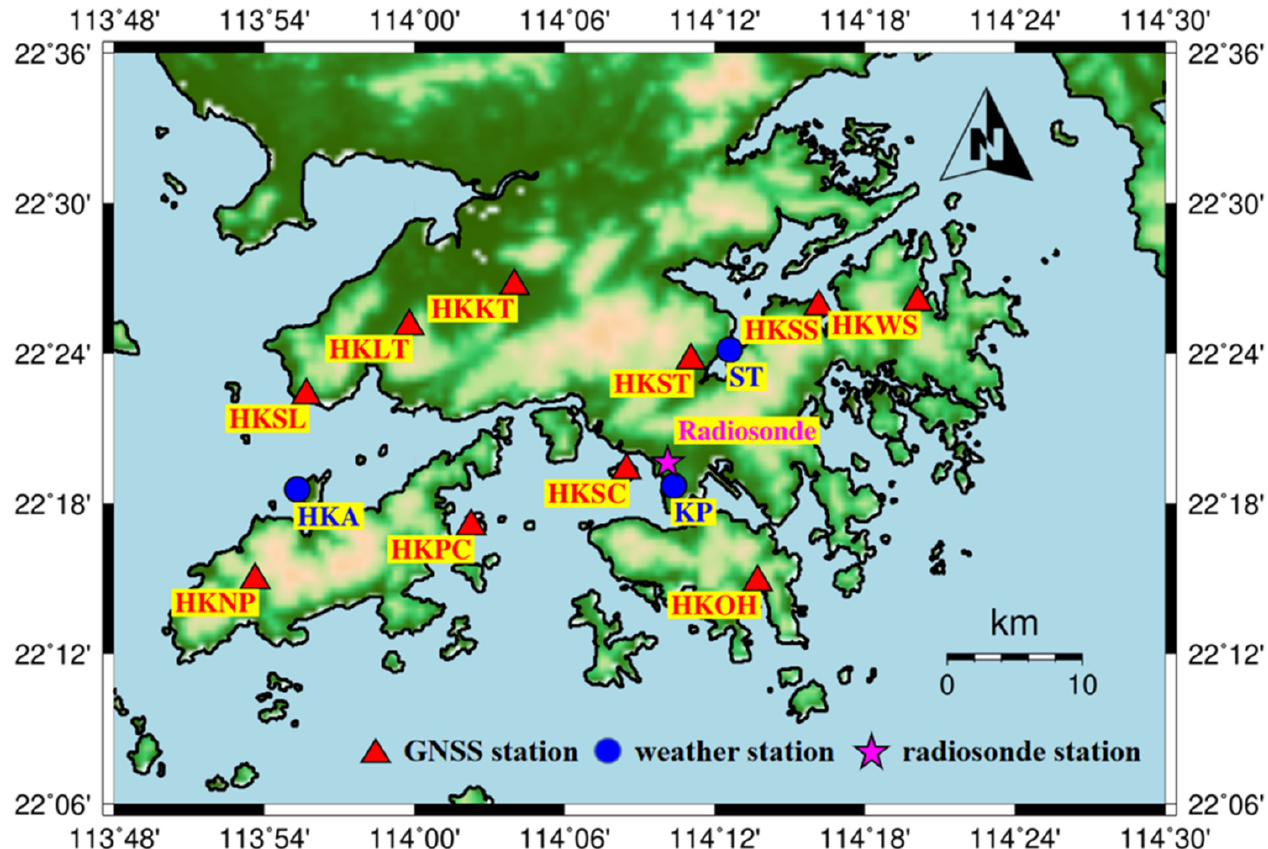
Figure 1. Spatial distribution of the selected Global Navigation Satellite System (GNSS) stations (red triangles), automatic weather stations (blue dots), and radiosonde station (magenta pentagram) in the study area. (This figure was plotted using the Generic Mapping Tools Version 5.4.)